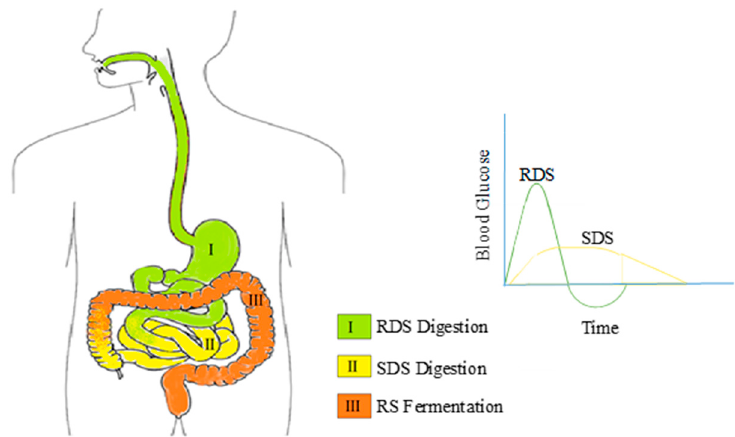
Figure 5. Digestion of different kinds of starches in the digestive system and their glycemic response in the blood glucose (redrawn from Miao et al., 2015 [34] and Sorndech et al., 2018 [35]).